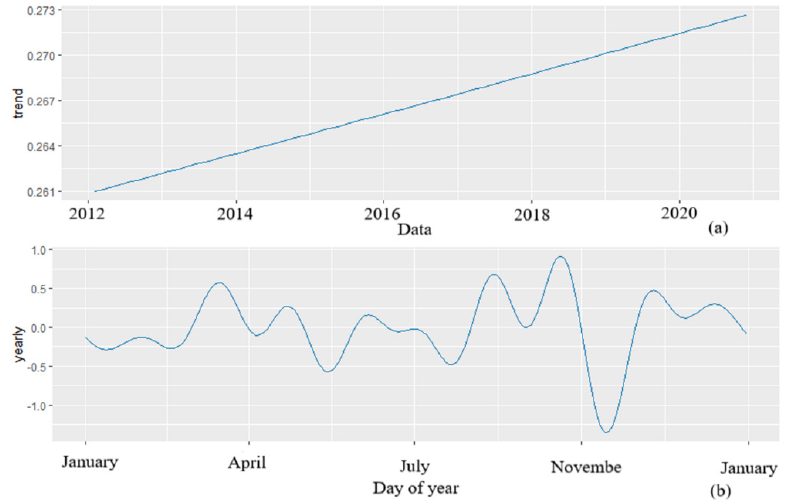
Figure 5. The decomposed components of the monthly incidence of AIDS in Henan province, China: ( a ) the effect of trend and ( b ) the effect of the yearly seasonality.